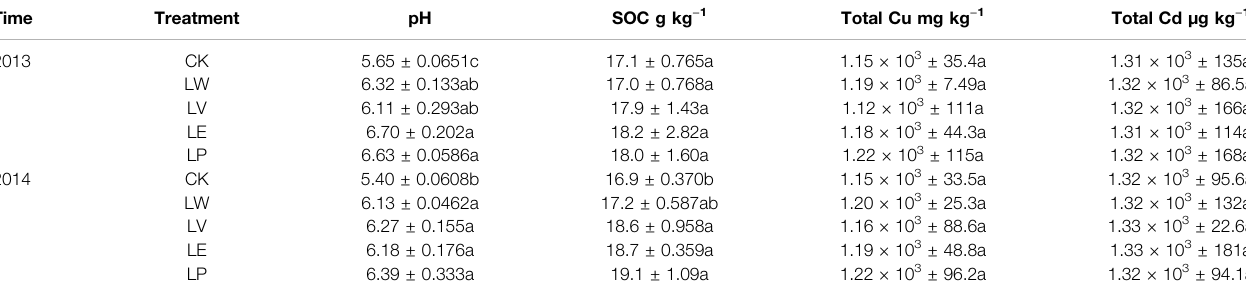
TABLE 2 | Surface soil properties after treatments (SOC (cid:2) soil organic carbon, CK (cid:2) untreated soil, LW, lime + Setaria lutescens ; LE, lime + Elsholtzia splendens ; LV, lime + Vetiveria zizanioides ; LP, lime + Pennisetum sp ., Different lowercase letters indicate signi fi cant differences between treatments, n (cid:2) 3, p < 0.05).